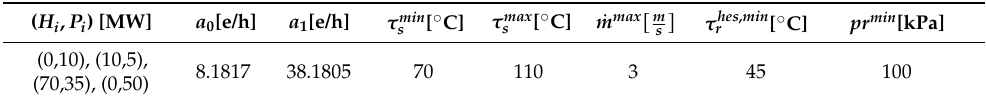
Table 1. The district heating network